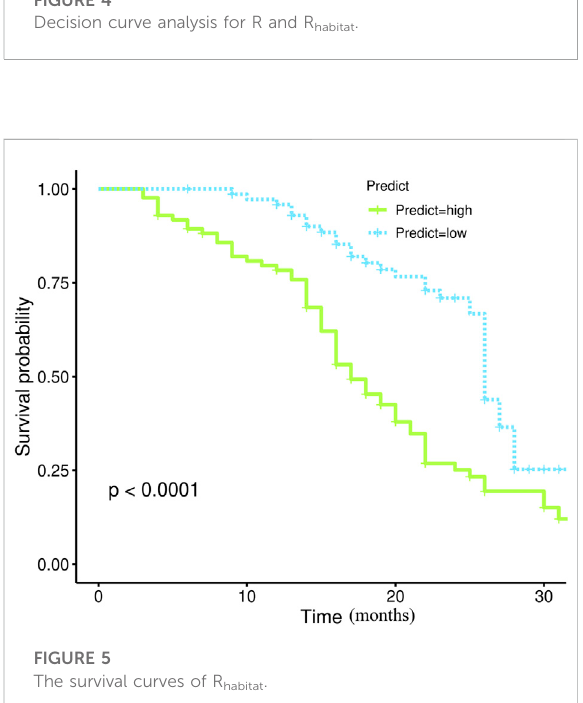
FIGURE 5 The survival curves of R habitat